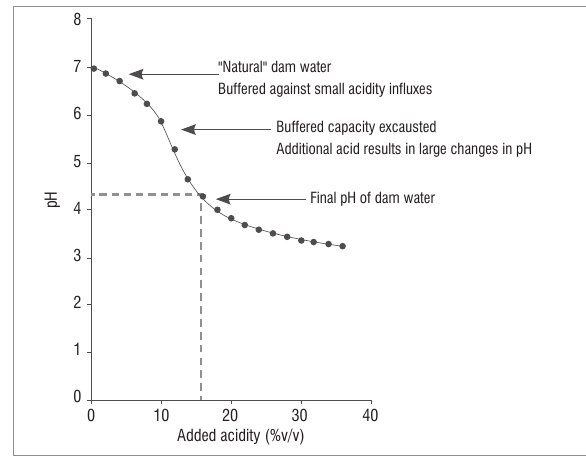
Figure 12: Acid titration curve for unpolluted water collected in the Boes- manspruit catchment.